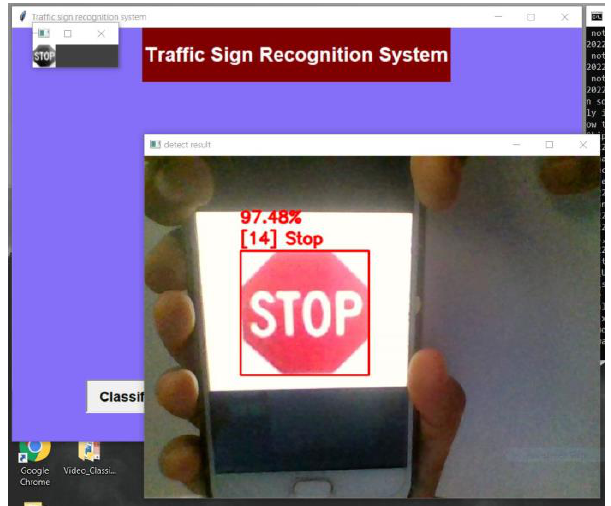
Fig. 15.2 Classification Result of Dynamic Image